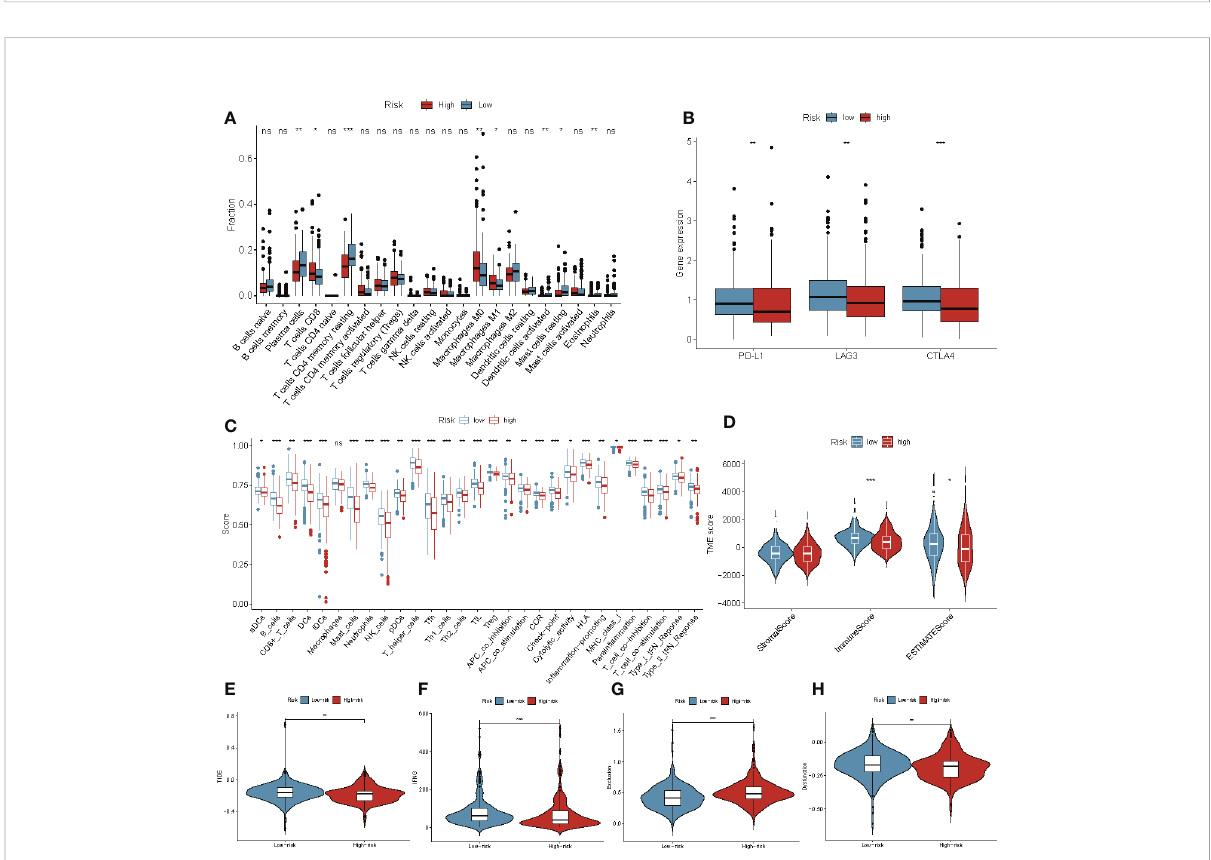
FIGURE 7 Immune landscape and immune status in patients with COAD in the high ‐ and low ‐ risk groups. (A) The boxplots for the comparison of the 22 immune cells in patients with COAD in the high-risk and low-risk groups. (B) ICI-related genes between the high ‐ and low ‐ risk groups. (C) ssGSEA was used to estimate the immune cell in fi ltration score and immune-related pathways enriched in the high- and low-risk groups. (D) The stromal score, ESTIMATE score, and immune score in patients with COAD in the high- and low-risk groups. (E – H) The Violin plot shows the TIDE (E) , IFNG (F) , T cell exclusion (G) and T cell dysfunction (H) scores in the high- and low-risk groups in TCGA-COAD cohort. *P< 0.05, **P< 0.01, ***P< 0.001, ns, not signi fi